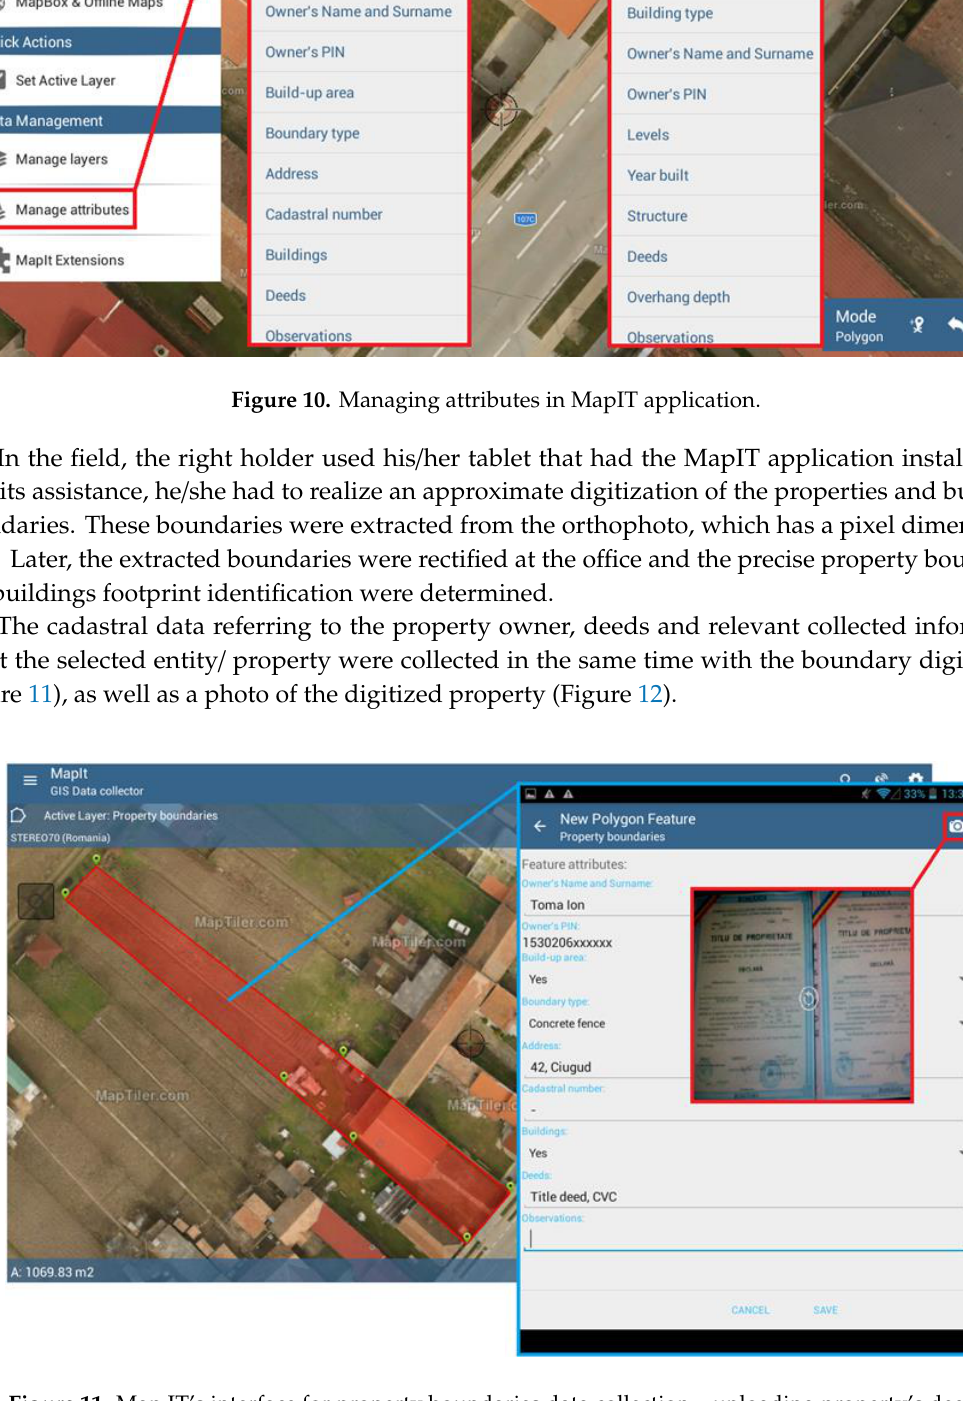
Figure 11. Map IT’s interface for property boundaries data collection – uploading property’s deed.